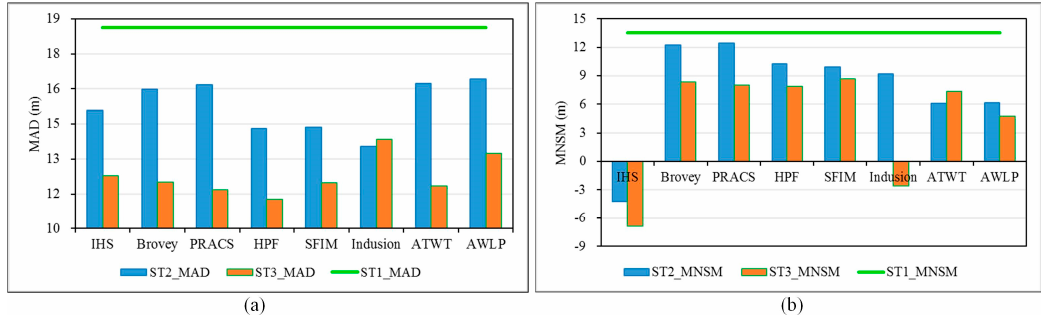
Figure 8. Mean absolute difference (MAD) and mean net shoreline movement (MNSM) values of the extracted coastlines from three different strategies with different pansharpening algorithms. The green lines, as contrasts, demonstrate the MAD value ( a ) and MNSM value ( b ) of coastline extracted in strategy 1.